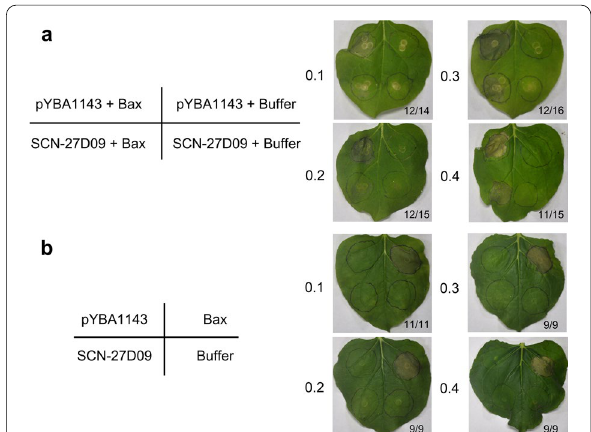
Fig. 3 SCN-27D09 suppresses Bax-triggered cell death in Nicotiana benthamiana . a Transient expression of SCN-27D09 suppressed cell death induced by Bax. The corresponding combinations used for infiltration of N. benthamiana leaves were indicated on the left panel. b Transient expression of Bax induced cell death. Treatments for infiltration of N. benthamiana leaves were shown on the left panel. In a and b , the data (0.1, 0.2, 0.3, and 0.4) indicate the OD 600 value of Agrobacterium tumefaciens carrying Bax. Numbers at the lower-right corner of the pictures represent the number of leaves showing cell death suppression out of the number of leaves agroinfiltrated